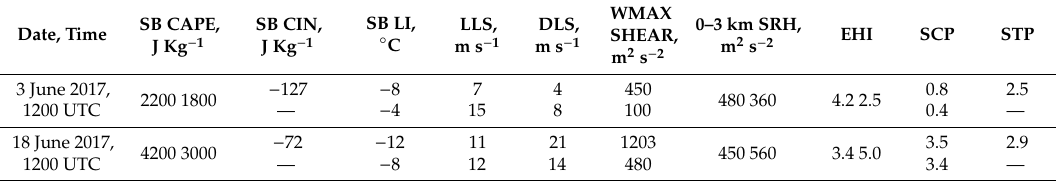
Table 2. Diagnostic variables calculated according to the GFS / NCEP (first line) and GEM / CMC (second line) model outputs (12-h forecasts from the 0000 UTC 3 June 2017 and 0000 UTC 18 June 2017, respectively). CIN and STP were obtained only for the GFS / NCEP